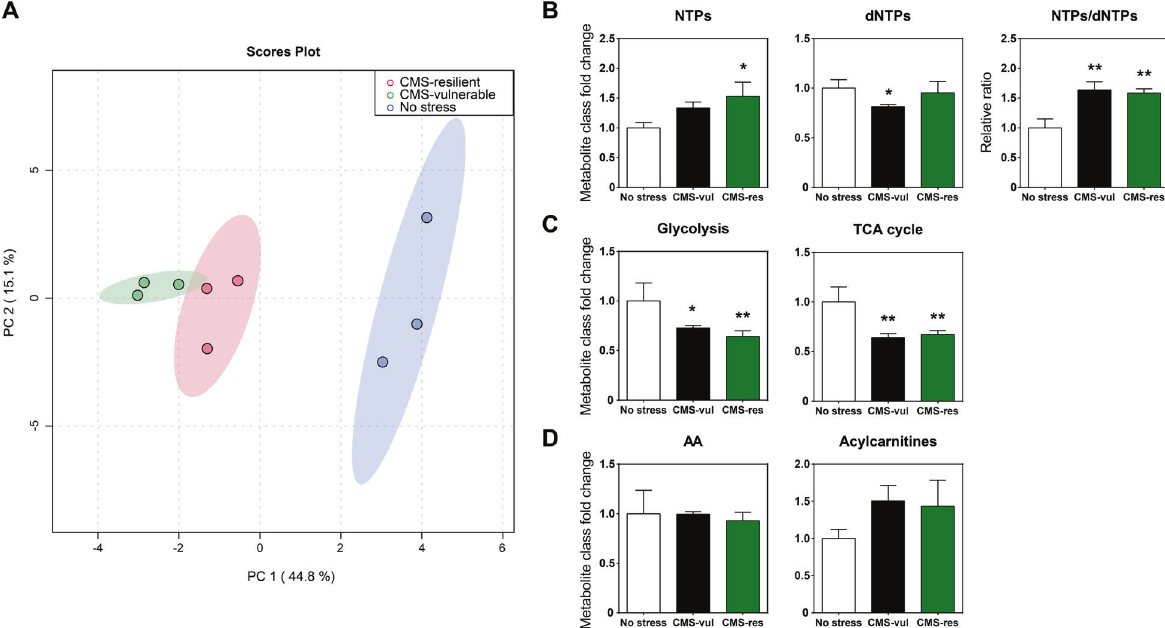
Fig. 2 Metabolomic analysis of vHip of rats exposed to CMS. A principal component analysis (PCA) of targeted metabolomics; B fold change of nucleotides (NTPs), deoxynucleotides (dNTPs), and NTPs/dNTPs relative ratio in control (no stress) and stressed (CMS-vul/CMS-res) animals; C fold change of glycolysis and TCA cycle metabolites; D fold change of free amino acids and acylcarnitines. The data are the mean ± SEM. * p < 0.05, ** p < 0.01 vs no stress; # p < 0.05 vs CMS-vul (one-way ANOVA, Fisher ’ s